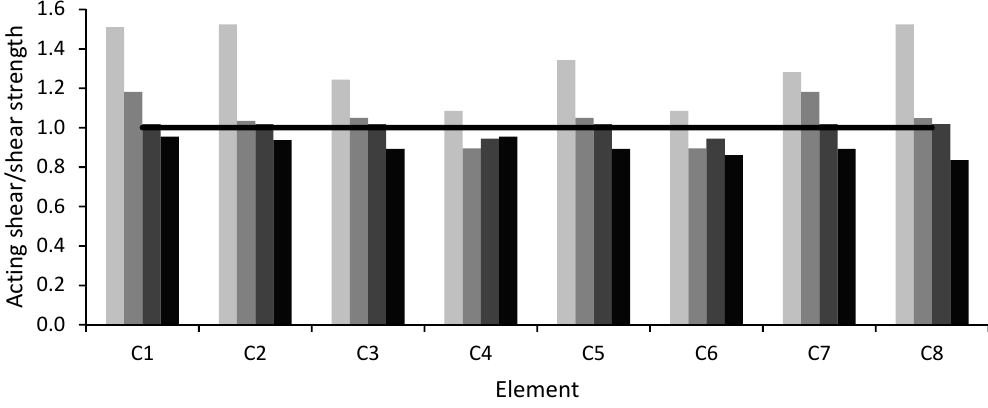
Figure 17. Shear verifications of columns in as-built conditions.